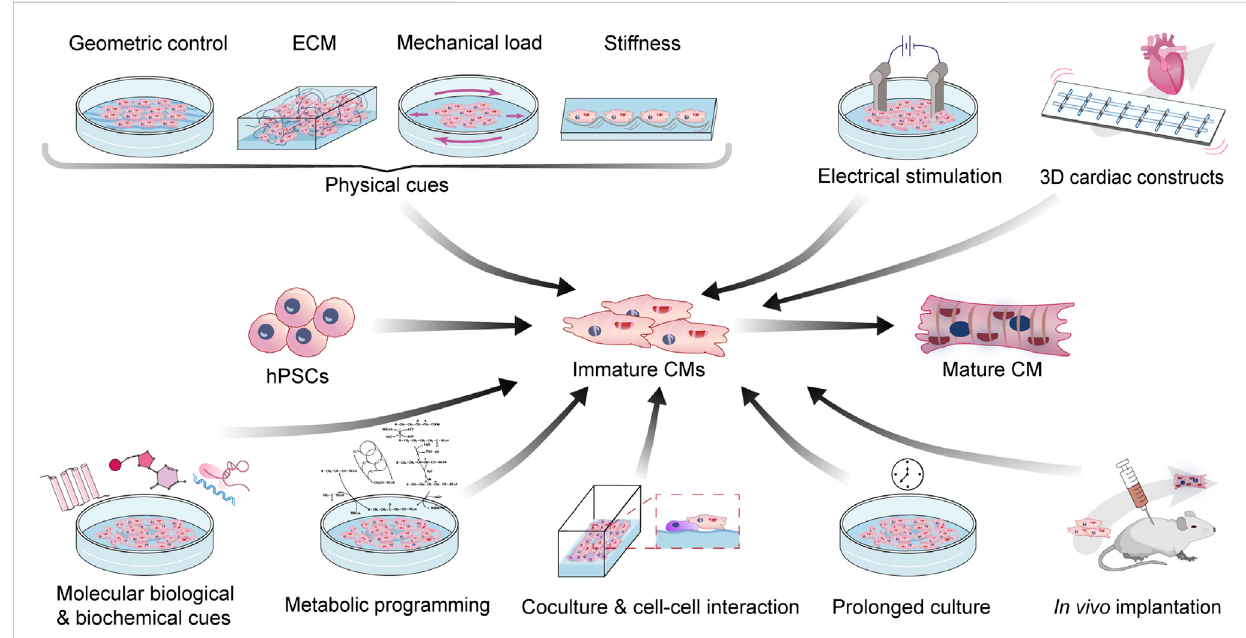
FIGURE 2 Bioengineering strategies to enhance the maturation of SC-CMs. CM, cardiomyocyte; ECM, extra cellular matrix; hPSC, human pluripotent stem cell.